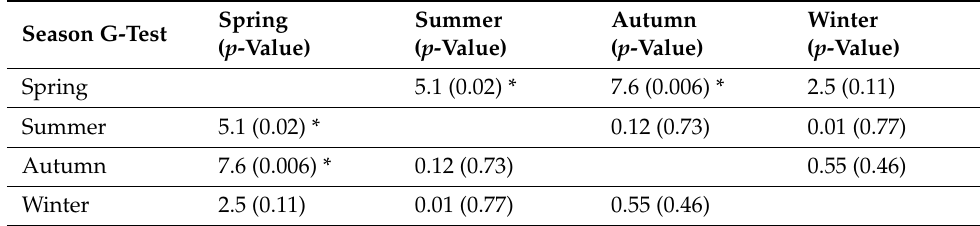
Table A1. G-tests’ g-values and p -values in parentheses between the number of empty stomachs and the different seasons. Significant p -values are tagged with an asterisk.